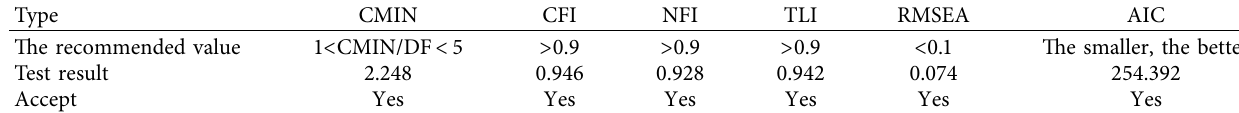
Table 3: Comparison of model fitting indexes.